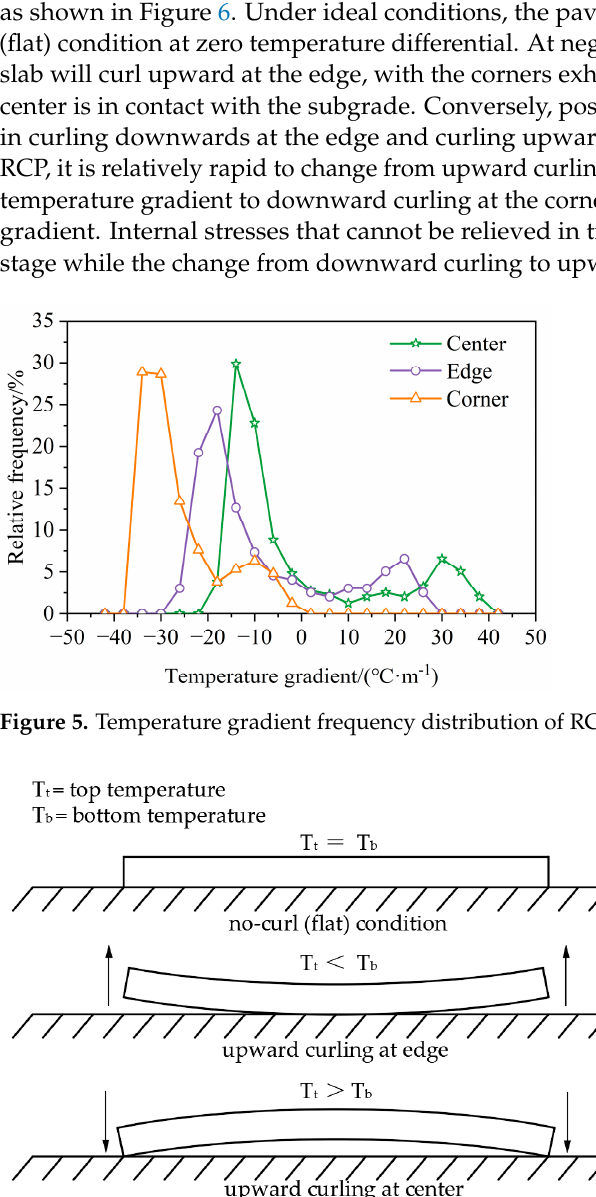
Figure 6. Diagram of curling of concrete pavement.